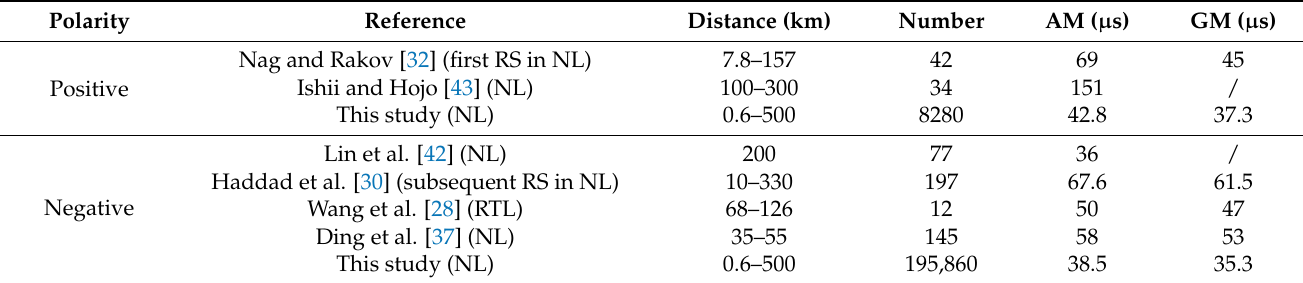
Table 4. Comparison of zero-crossing time among different studies.